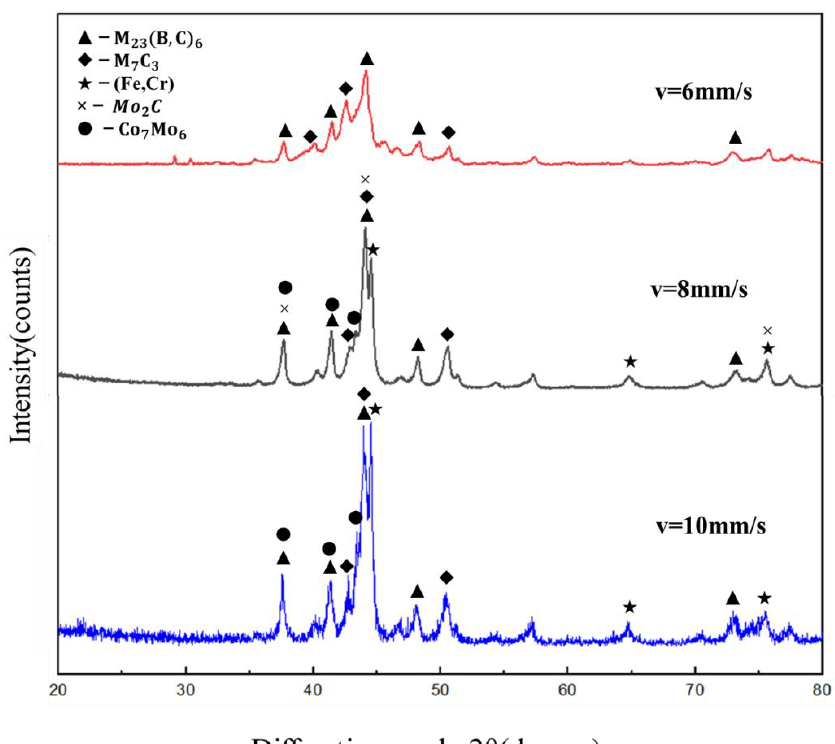
Figure 1. XRD patterns of the cladding layers at different scan speeds.